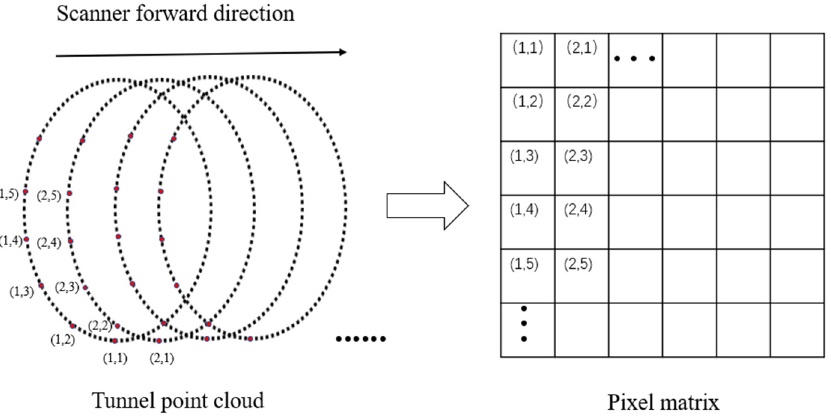
Figure 6. Schematic of point cloud intensity information written into pixel matrix.